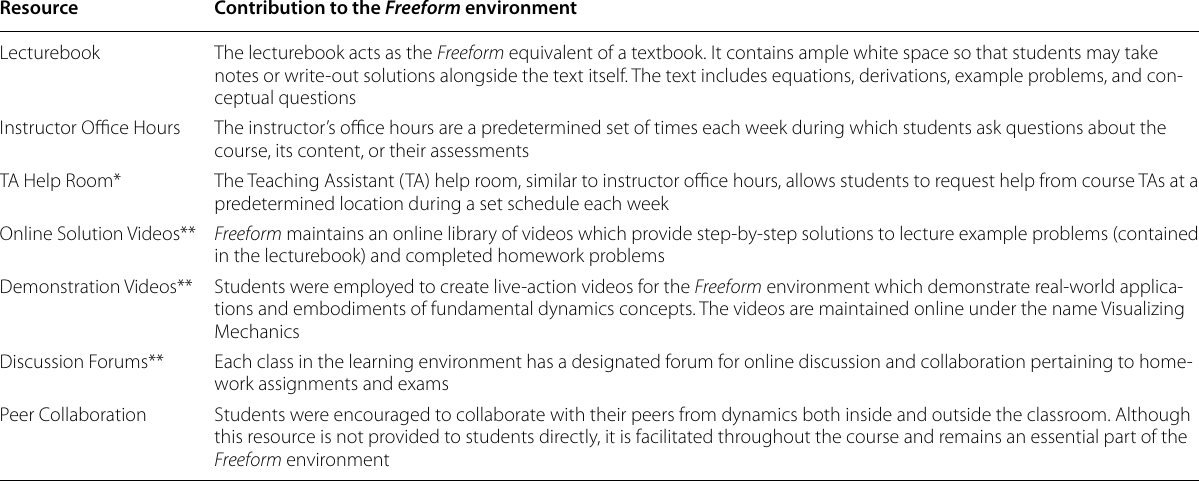
*The TA Help Room is a dedicated space on PUWL’s campus where students can find tutorial help during its daily operating hours. Other institutions employing the Freeform environment may not have TA Help Rooms of their own **The Online Solution Videos, Demonstration Videos, and Discussion Forums are all made available through the Freeform course blog, along with homework assignments and general course information